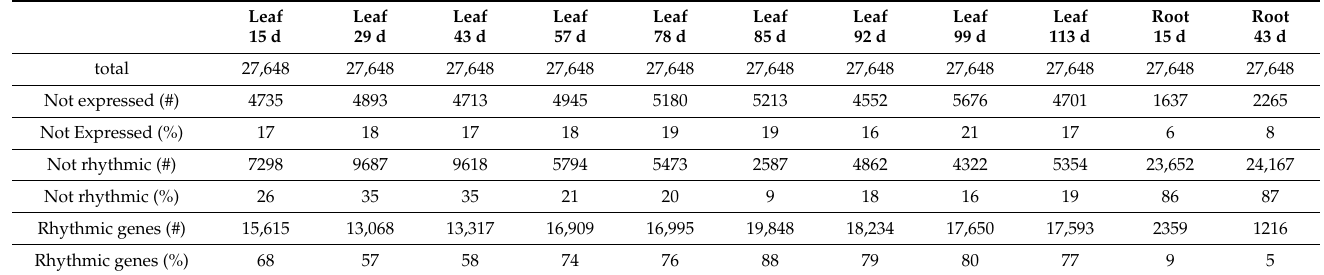
Table 1. Summary of the cycling genes across the rice developmental time